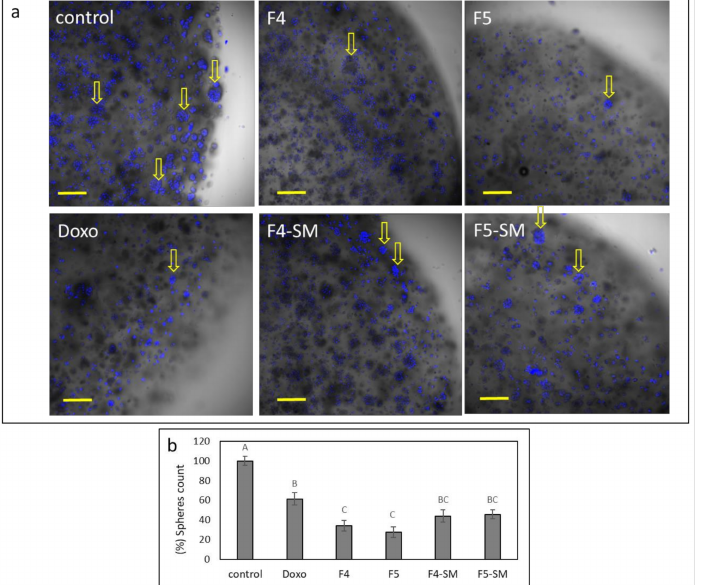
Figure 11. ( a ) Examples for representative confocal images of U87 cells following treatment with F4 (20 µ g/mL), F5 (16.5 µ g/mL), F4-SM (12.5 µ g/mL), and F5-SM (10 µ g/mL), for 8 d. Doxorubicin (Doxo, 2.0 µ g/mL) served as a positive control. Control is vehicle control (2.0% v / v methanol). Overlay of brightfield and Hoechst staining for nuclei (blue color) is shown in five concurrent optical sections; scale bars = 200 µ m; n = 3. Arrows point to some of the colonies that formed. ( b ) Percentage of the number of colonies in each of the treatments (out of the average number of colonies in the control), presented as mean; error bars indicate ± SE ( n = 3). Levels with different letters are significantly different from all combinations of pairs according to the Tukey–Kramer honest significant difference (HSD; p ≤